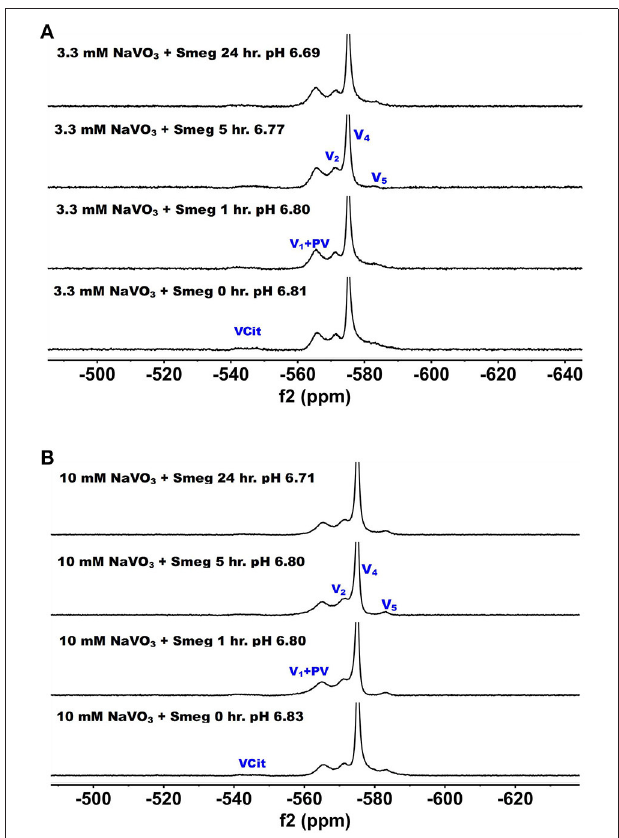
FIGURE 5 | The 51 V NMR spectra of media in which M. smeg had grown at 0, 1, 5, and 24h time points. Data for two concentrations are shown in (A) 3.3mM V 1 treatment (3.3mM V-atoms) and (B) 10mM V 1 treatment (10mM V-atoms). See Figure 3 caption for key to